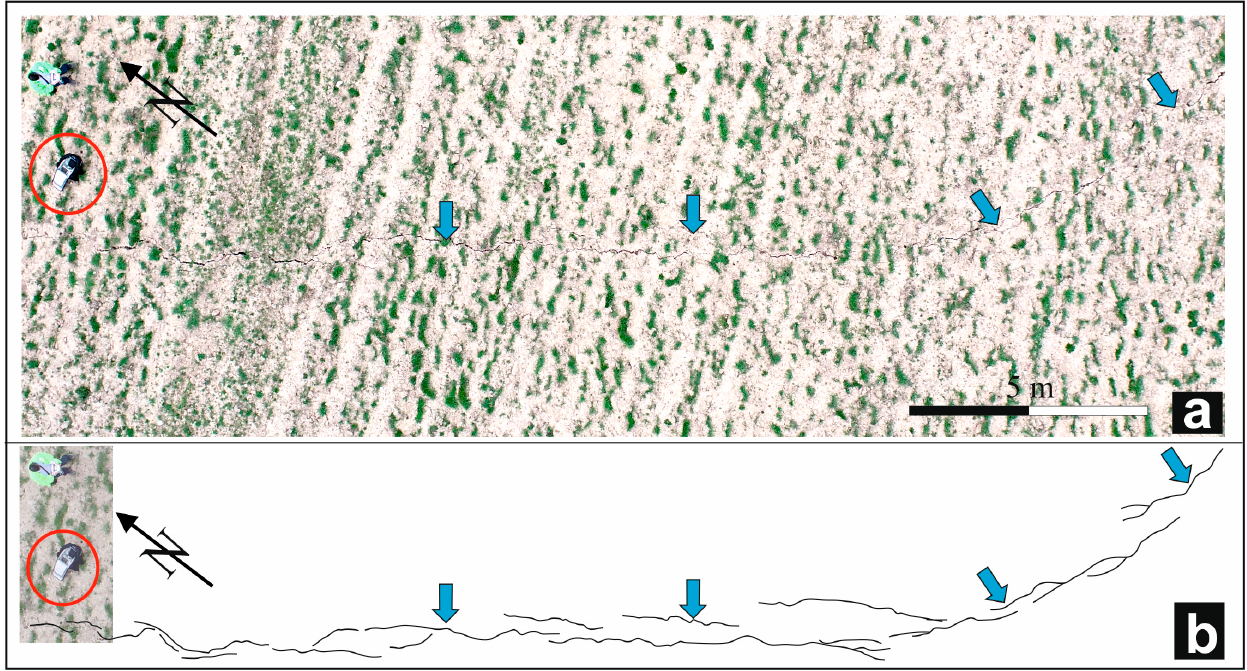
Figure 6. Drone capture of coseismic surface trace ( a ), as mapped on 4 March and its outline ( b ). This crack shows a maximum verticaloffset of 10 cm, and its surface trace is parallel with VF. Total trace of mapped rupture is ca. 1 km. Drone back-pack (in the red circle, 80-cm-long by 40-cm-wide) is used for scale.